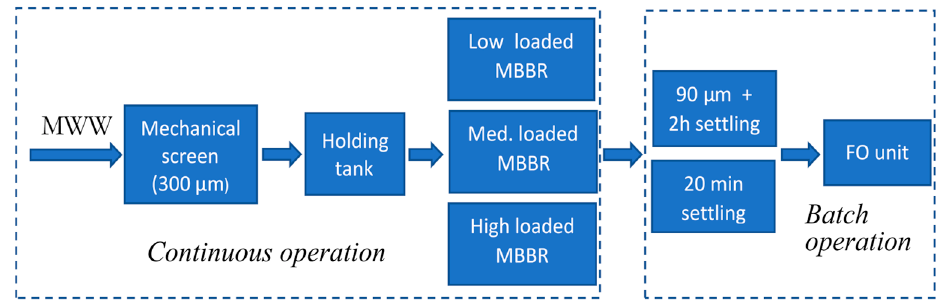
Figure 1. The overall experimental set-up.